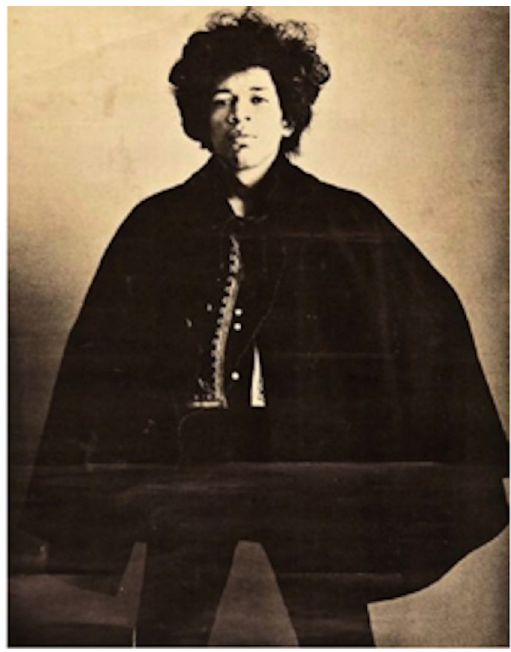
Figure 5. Jimi Hendrix and the Band of Gypsies Concert Poster, April 12, 1969. The Philadelphia Spectrum, Philadel- phia, PA.